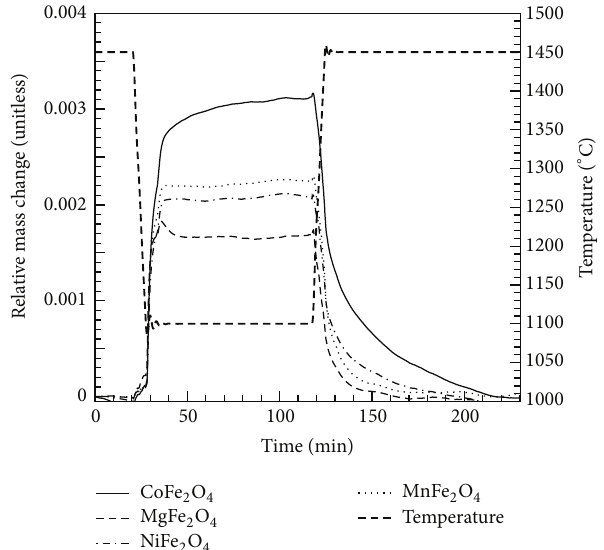
Figure 9: Normalized mass change of all samples for the 5th cycle.